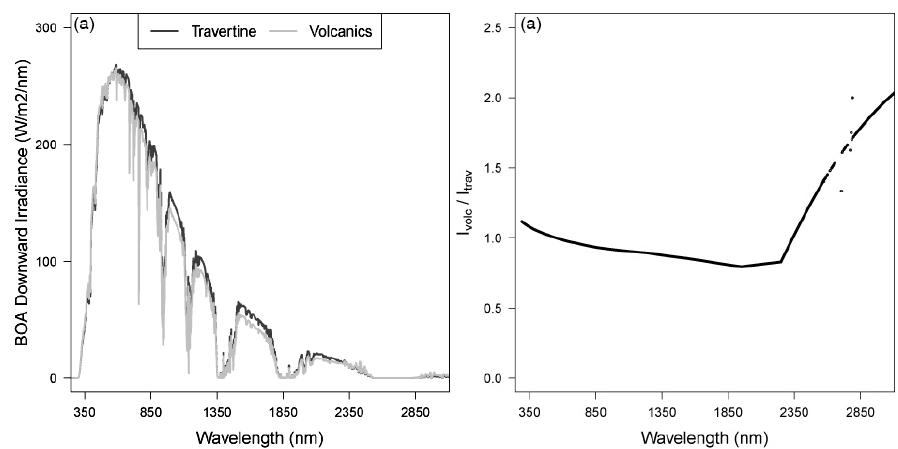
Figure 8. BOA downward solar irradiance (a) of an atmosphere composed by only volcanics, or travertine, PM 10 dust, and volcanics to travertine irradiance ratio (b) .